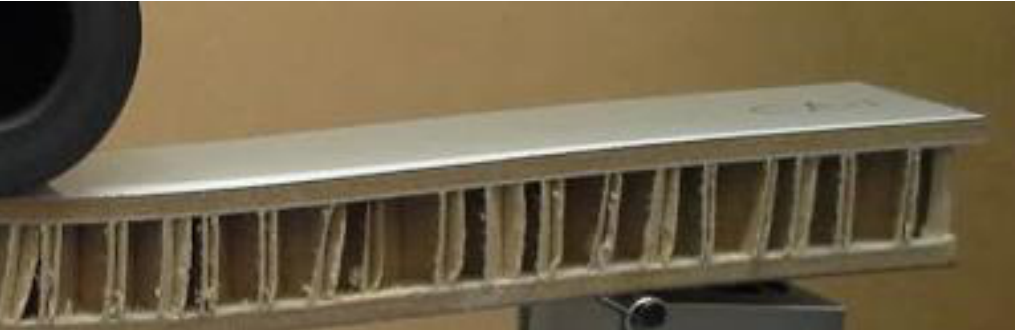
Figure 15. Delamination of sample ca1.